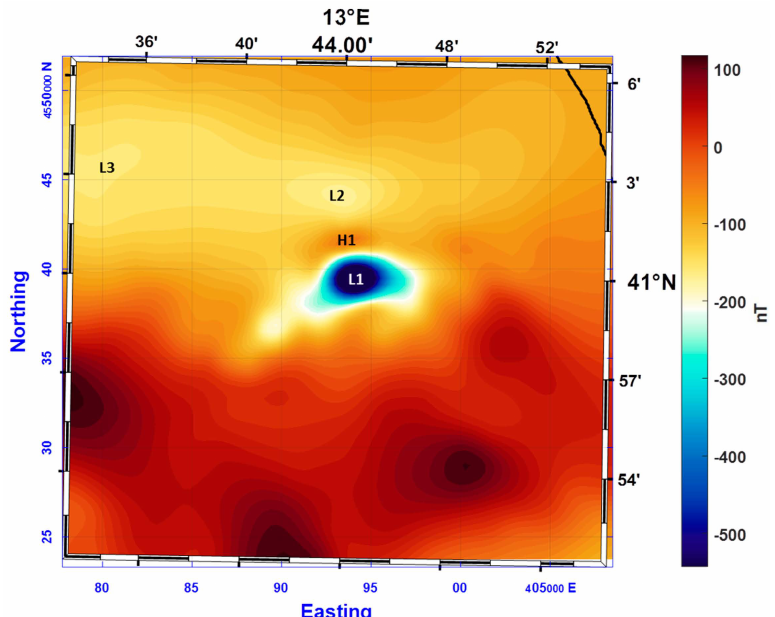
Figure 8. Total field shipborne magnetic anomalies of the Gaeta Gulf, along the 41 ◦ N parallel magnetic lineament. Letters identify magnetic anomalies described in the text. The black line in the northeast corner of the map represents the